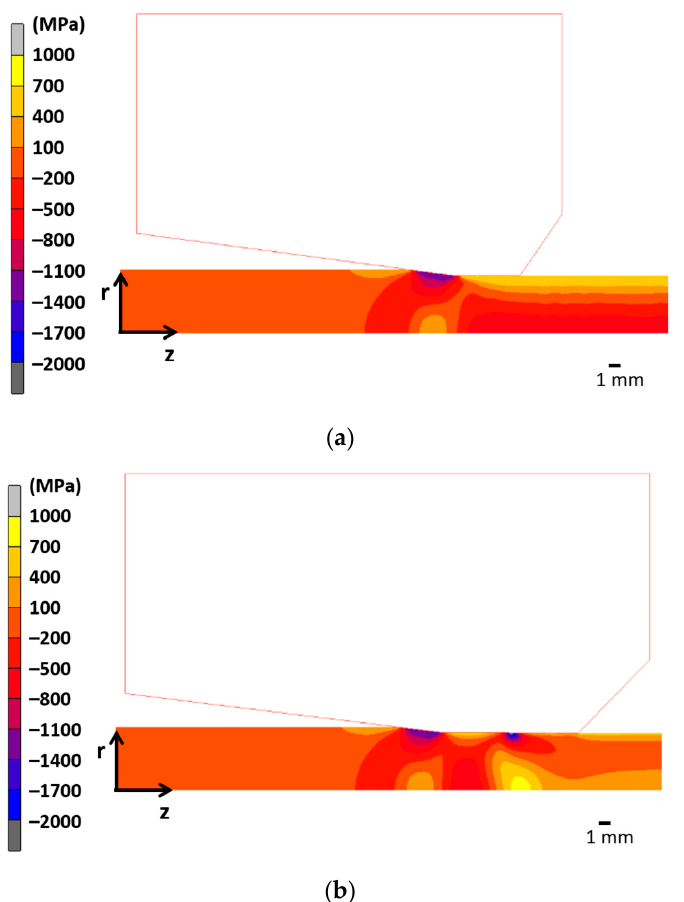
Figure 4. Hydrostatic stress fields obtained in: ( a ) a conventional cold drawing process and ( b ) a cold drawing with modified dies including a skin pass zone.